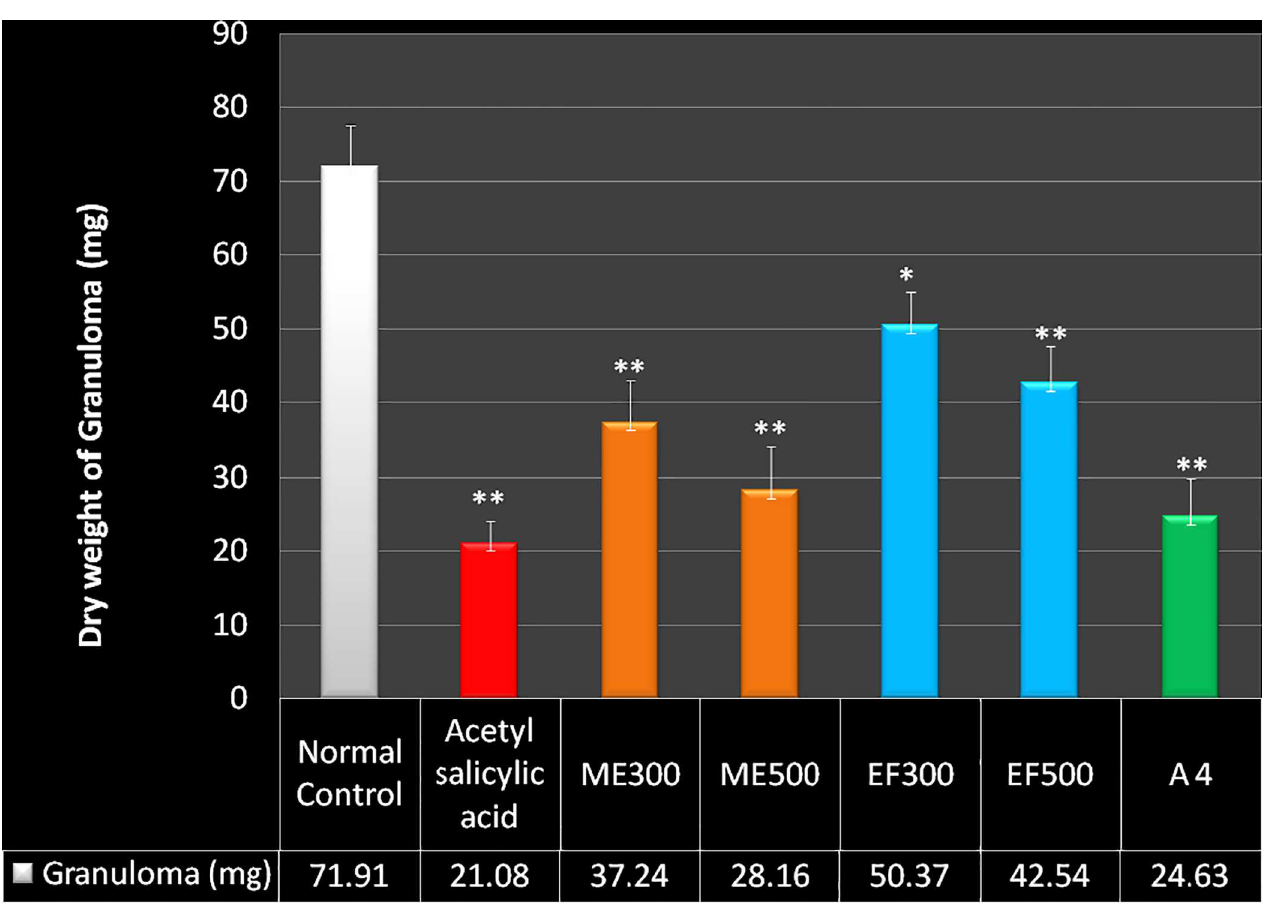
Fig 1. Effect of M . philippensis on dry weight of cotton pellet granuloma. Valuesare expressed as Mean ± S.E.M. * indicatesp < 0.05, ** indicatesp < 0.001when compared to the control group Aspirin-100mg/kg, Normal Control-Normal saline1ml/kg, ME300—Methanol extract